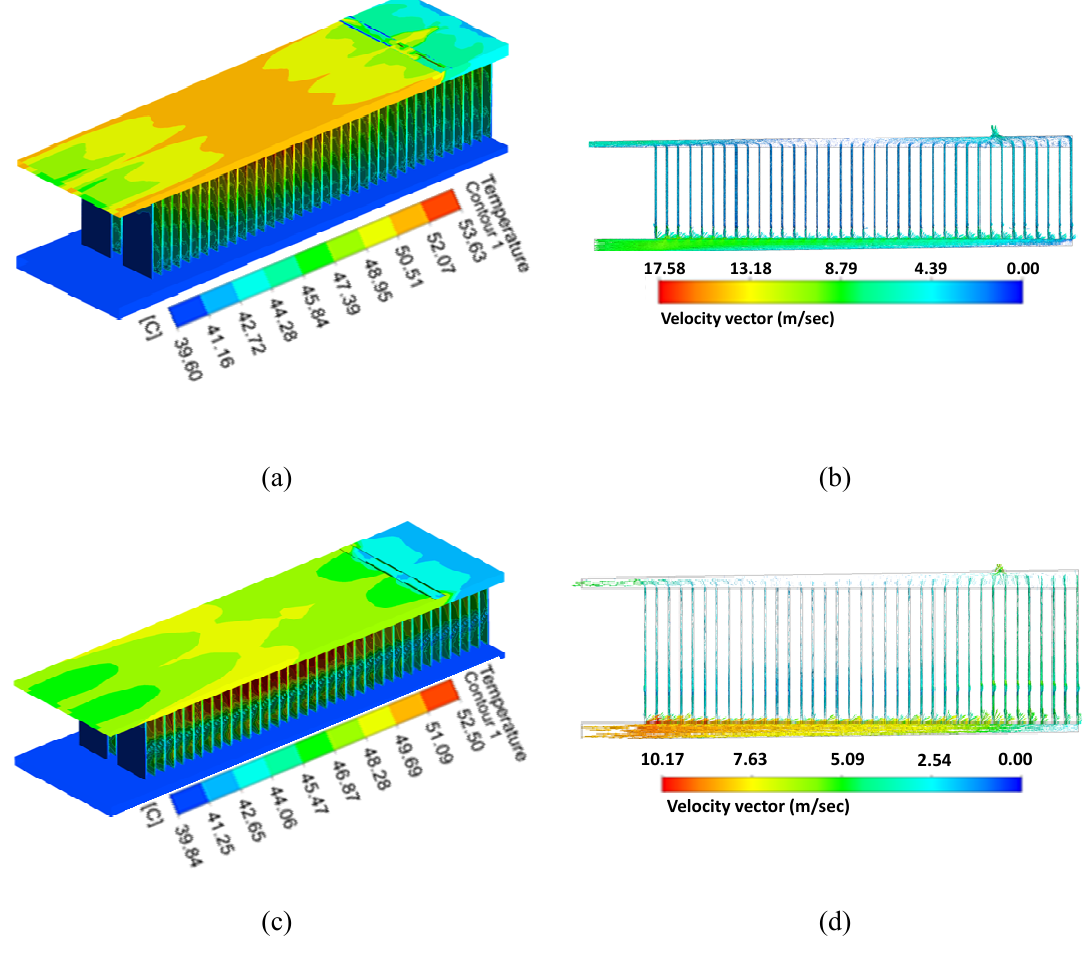
Figure 6. ( a ) Temperature contour in delta winglet BTMS; ( b ) Air flow distribution in delta winglet BTMS; ( c ) Temperature contour in protruded BTMS; ( d ) Air flow distribution in protruded BTMS.